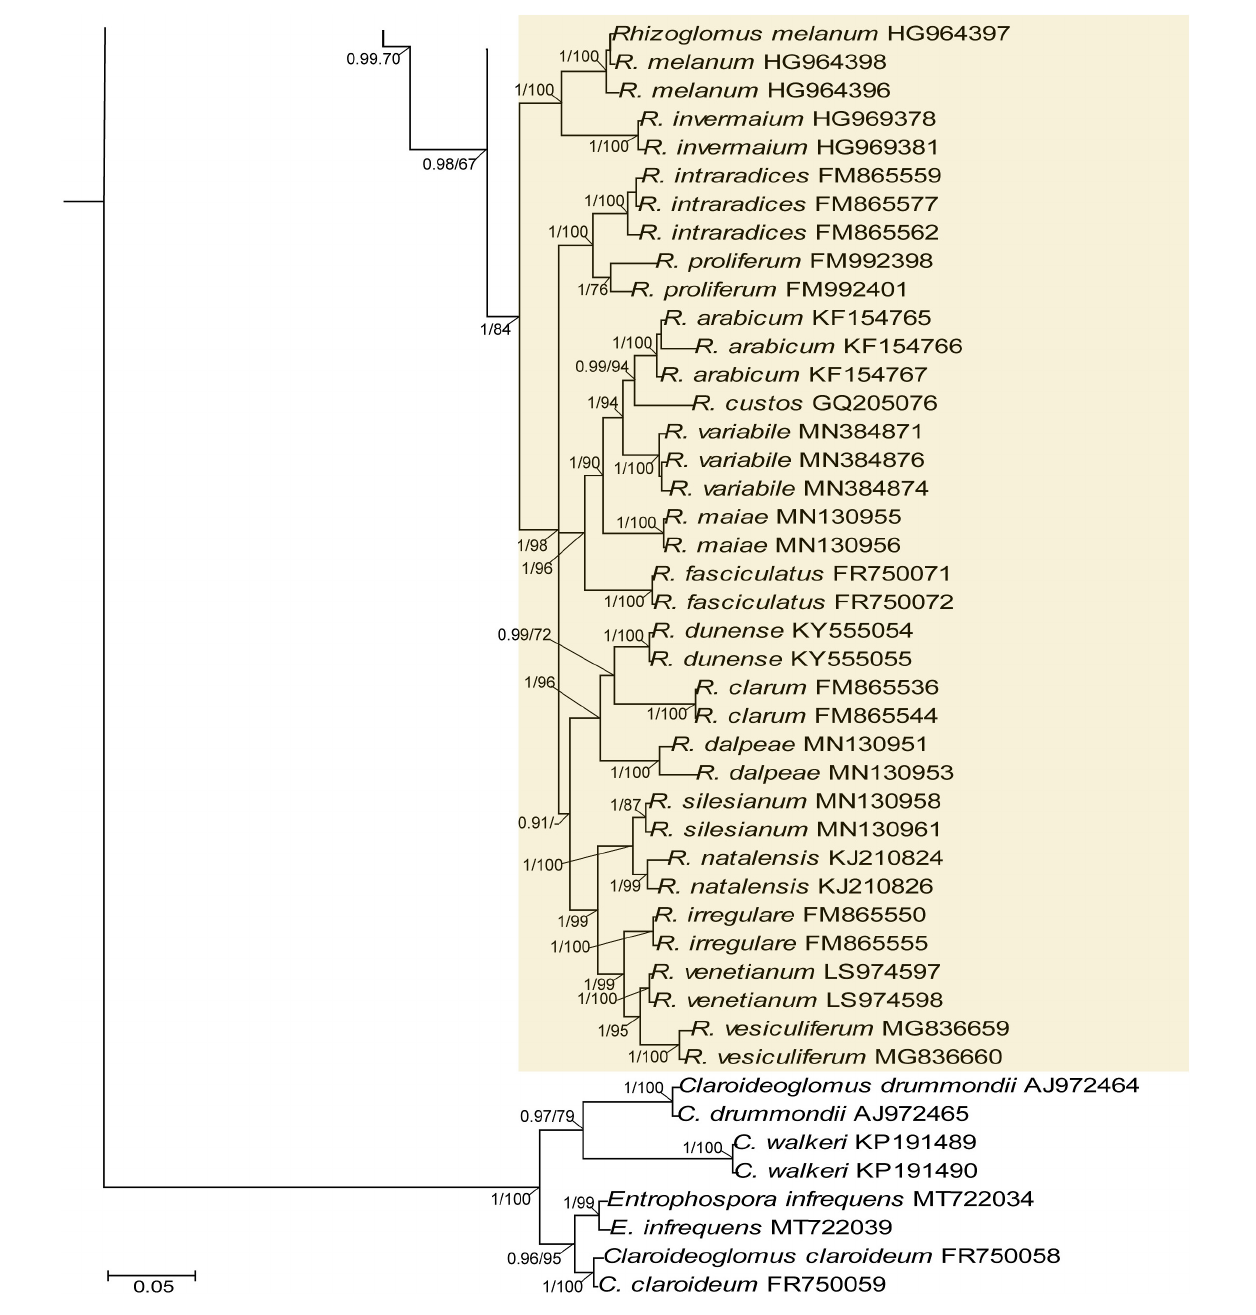
Frontiers in Microbiology |